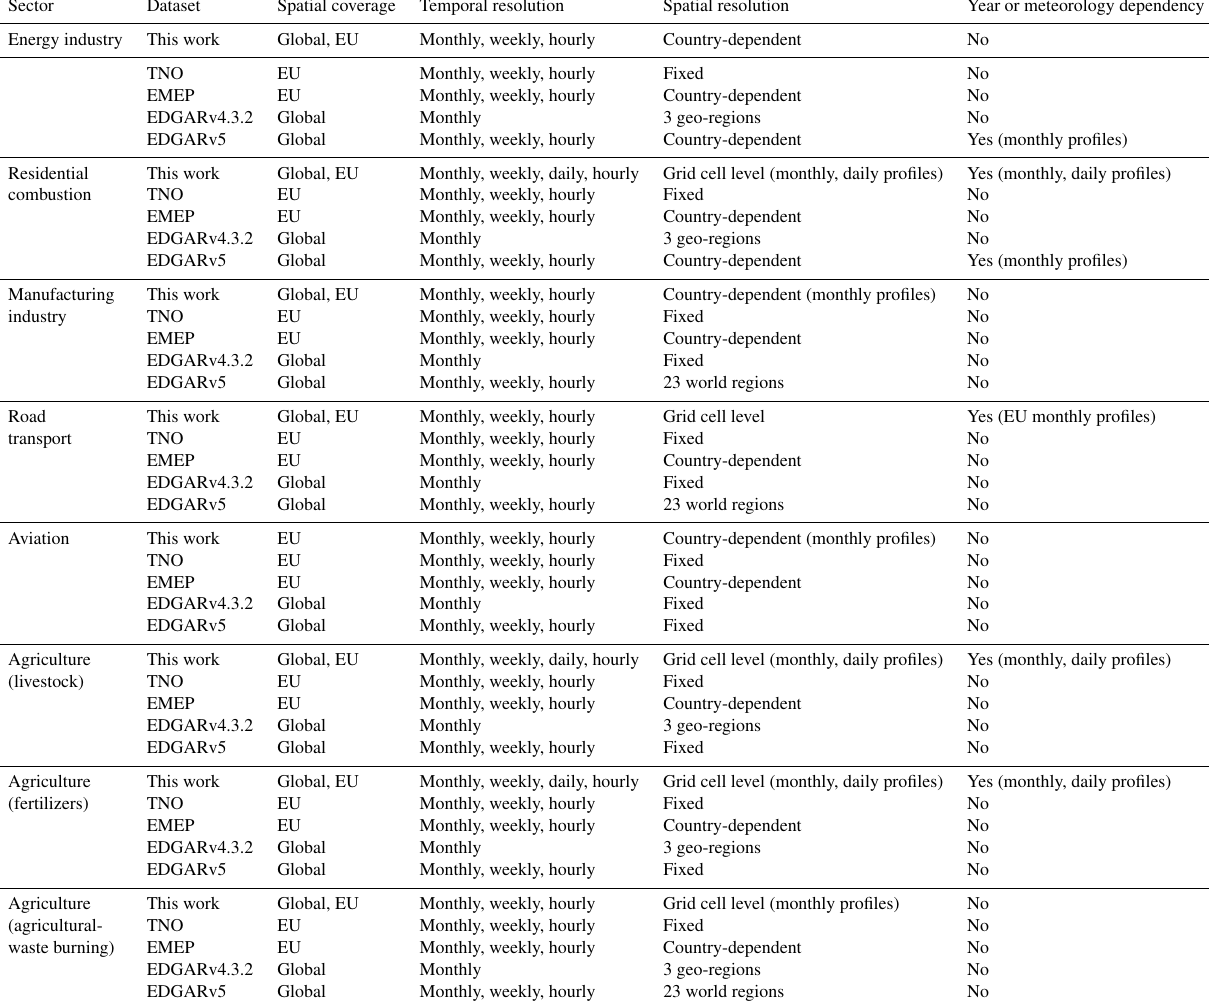
Table 1. Main characteristics of the temporal profiles developed in this work compared to those reported in other datasets including TNO (Denier van det Gon et al., 2011), EMEP (Simpson et al., 2012), EDGARv4.3.2 (Janssens-Maenhout et al., 2019) and EDGARv5 (Crippa et al., 2020) regarding spatial coverage, temporal and spatial resolution, and year or meteorology